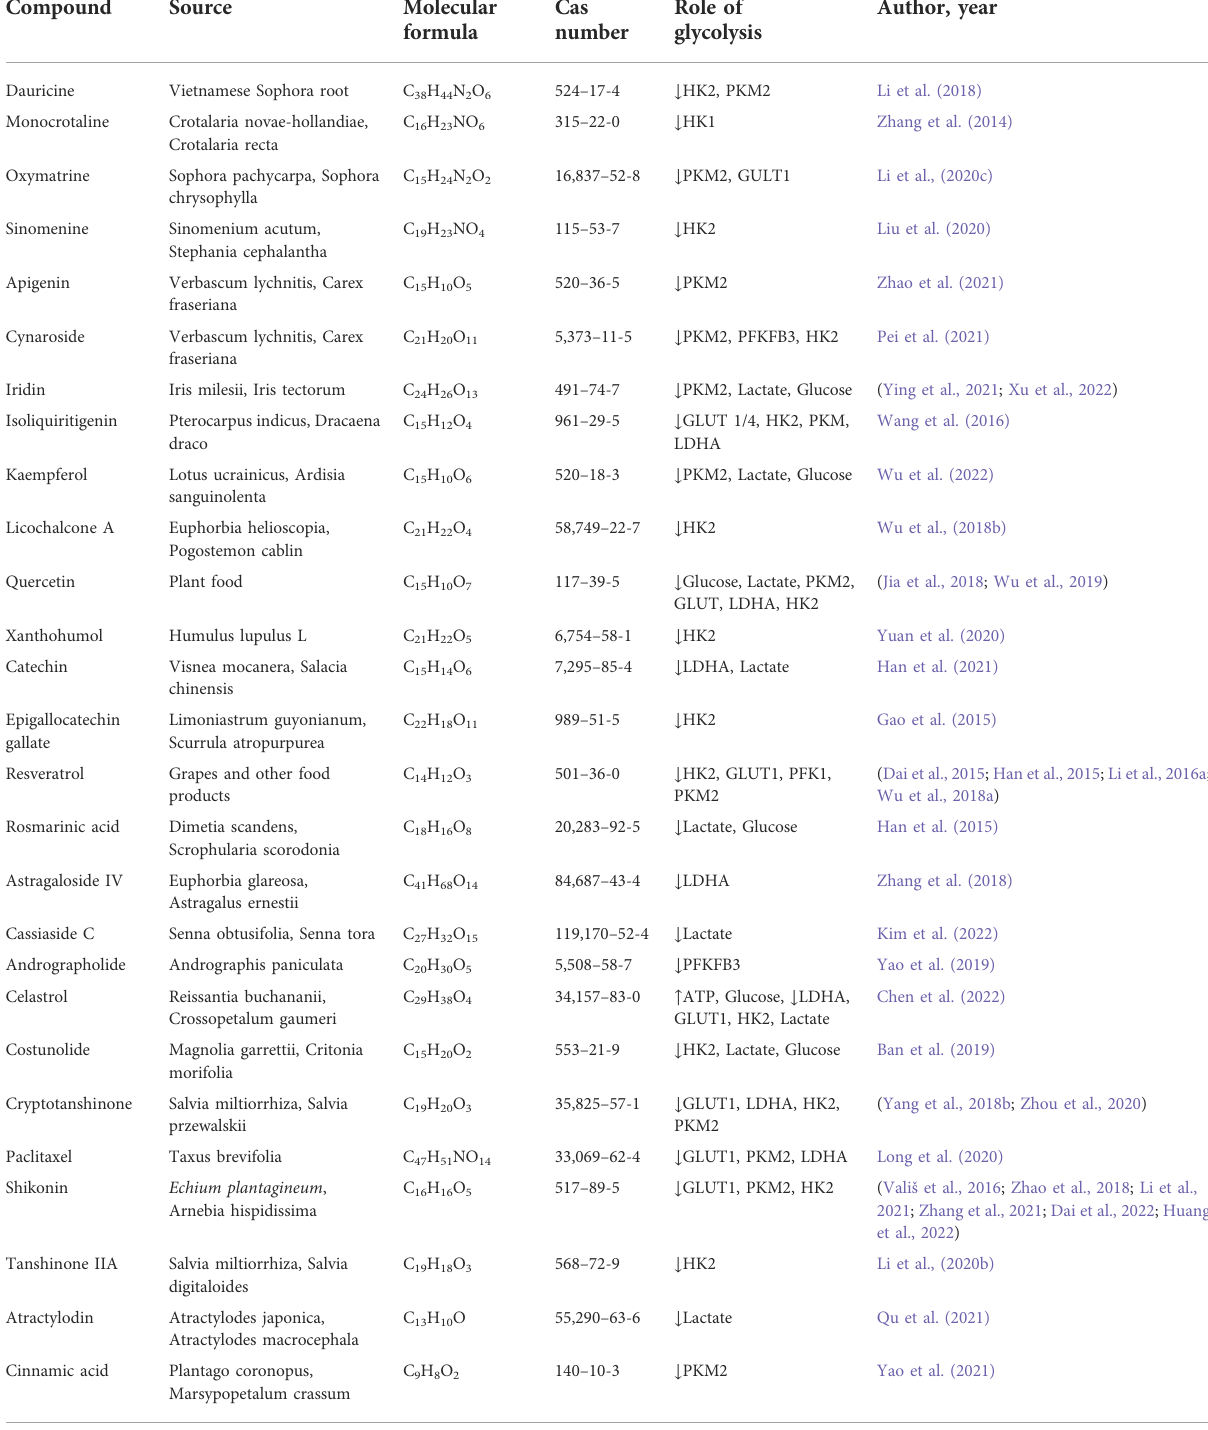
TABLE 2 Natural products that interfere with the glycolysis